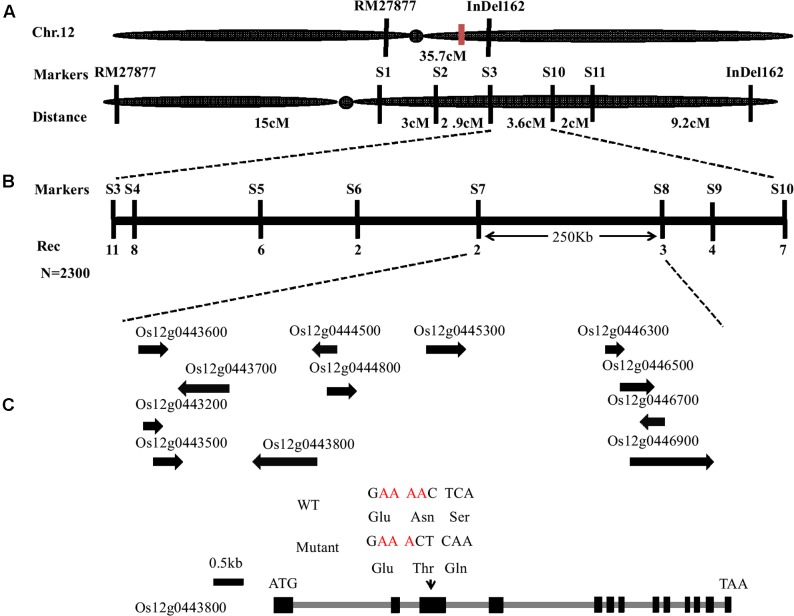
Map-based cloning of OsFIGNL1 gene on chromosome 12. (A) Primary mapping was performed using markers RM27877 and InDel162. (B) The OsFIGNL1 locus was finally mapped to a 250-kb region between the molecular markers S7 and S8. Names and positions of the markers are noted. (C) A schematic representation of the gene structure of OsFIGNL1. The mutant sequence has a single nucleotide deletion in the third exon. ATG and TAA represent the start and stop codon, respectively. Black boxes indicate exons, and intervening gray lines indicate introns. cM, Centimorgan; Rec, Recombinants; N, Total number of F2 plants used for fine mapping.